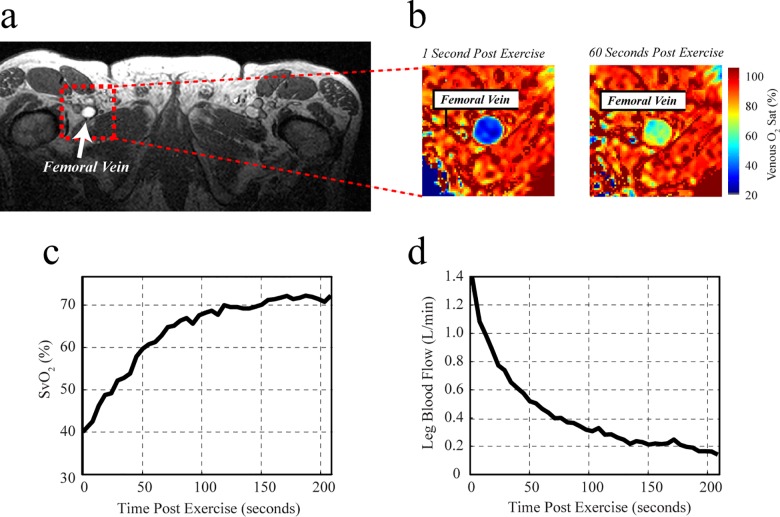
Sample MR images of femoral vein and SvO2.(a) Anatomic image showing the slice location for blood flow and venous oxygen saturation imaging experiments (the targeted right femoral vein is indicated). Sample venous oxygen saturation (SvO2) images at two time points (1 second after end-exercise and 60 seconds after end-exercise) are shown in (b), and the corresponding time-course data from this subject for SvO2 and blood flow, averaged for the entire vein cross-section, are in (c) and (d), respectively.